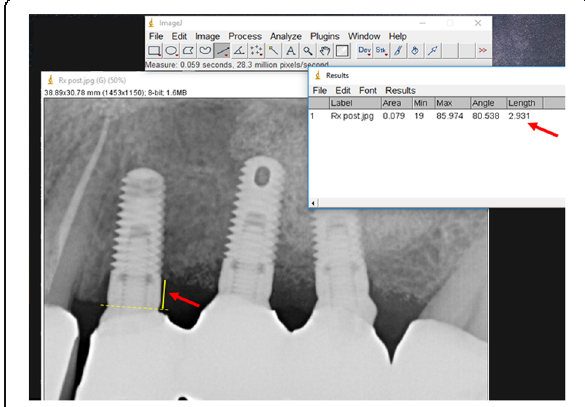
Fig. 1 Measuring peri-implant bone levels on intraoral radiographs. The peri-implant bone level at the distal side of an implant is measured by drawing a line (yellow, dotted) over the implant- abutment interface, and measuring its distance (yellow, full; indicated by the red arrow in the radiograph) from the most apical point of crestal bone in intimate contact with the implant through to the calibrated image-analysis software (in the example being shown, 2.931 mm, indicated by the red arrow in the measurement window). The measurement will be repeated at the mesial side, and the two will be averaged. The MBL will be calculated as the difference between this averaged value and that measured repeating the whole procedure on the corresponding immediate post-insertion intraoral